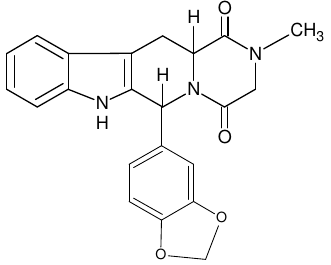
Figure 1 . Chemical structure of tadalafil